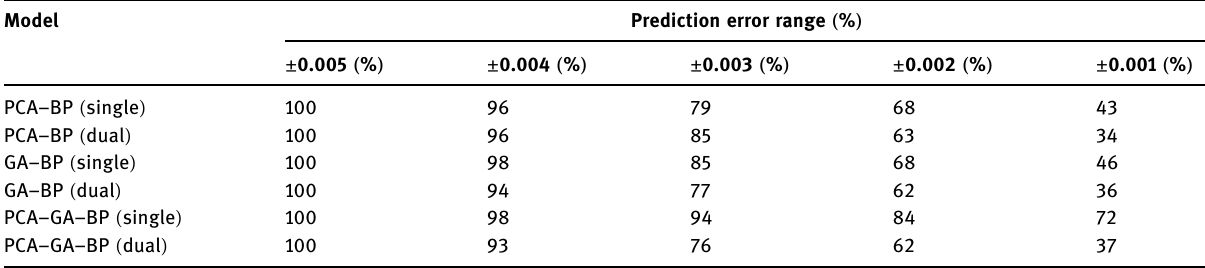
Table 3: Comparison of P content prediction accuracy of di ff erent models